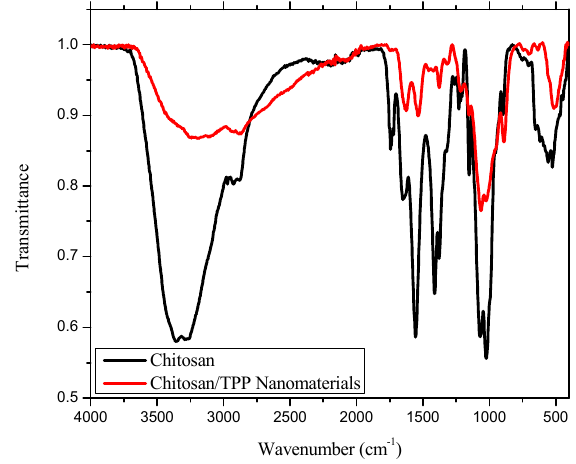
Figure 3. IR spectra of chitosan (CS) and CS/tripolyphosphate (TPP) nanomaterials.